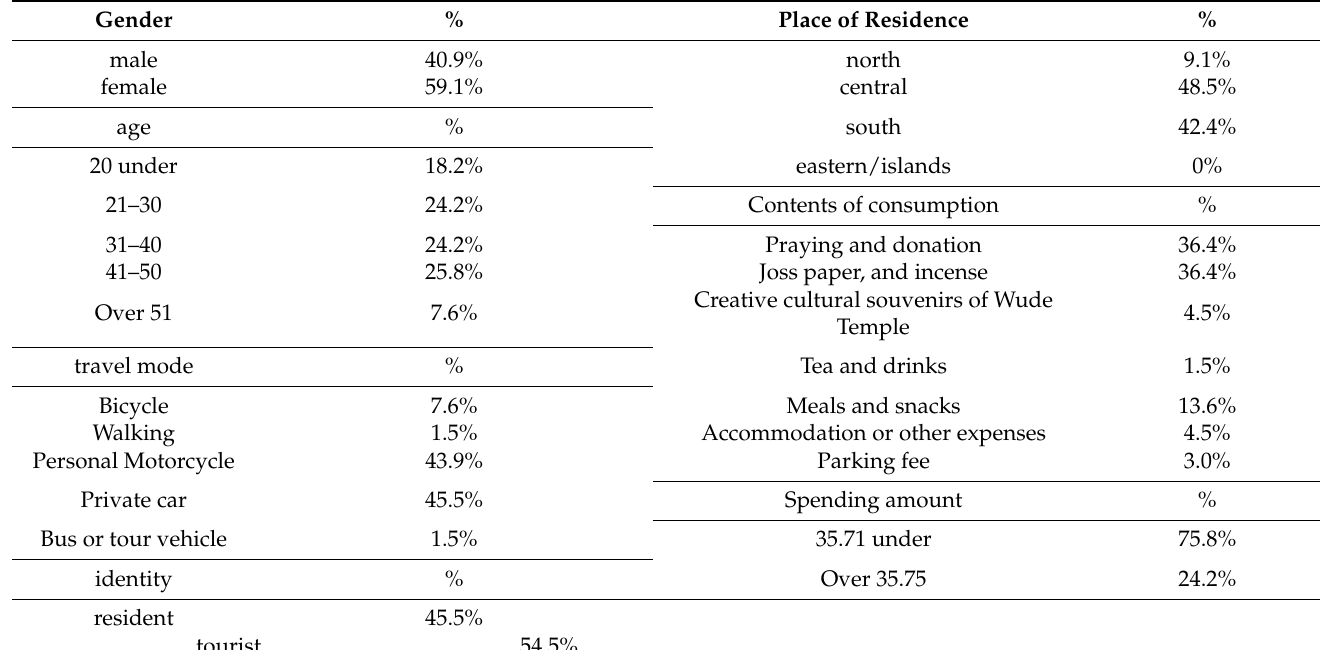
Table 3. Background disguised analysis